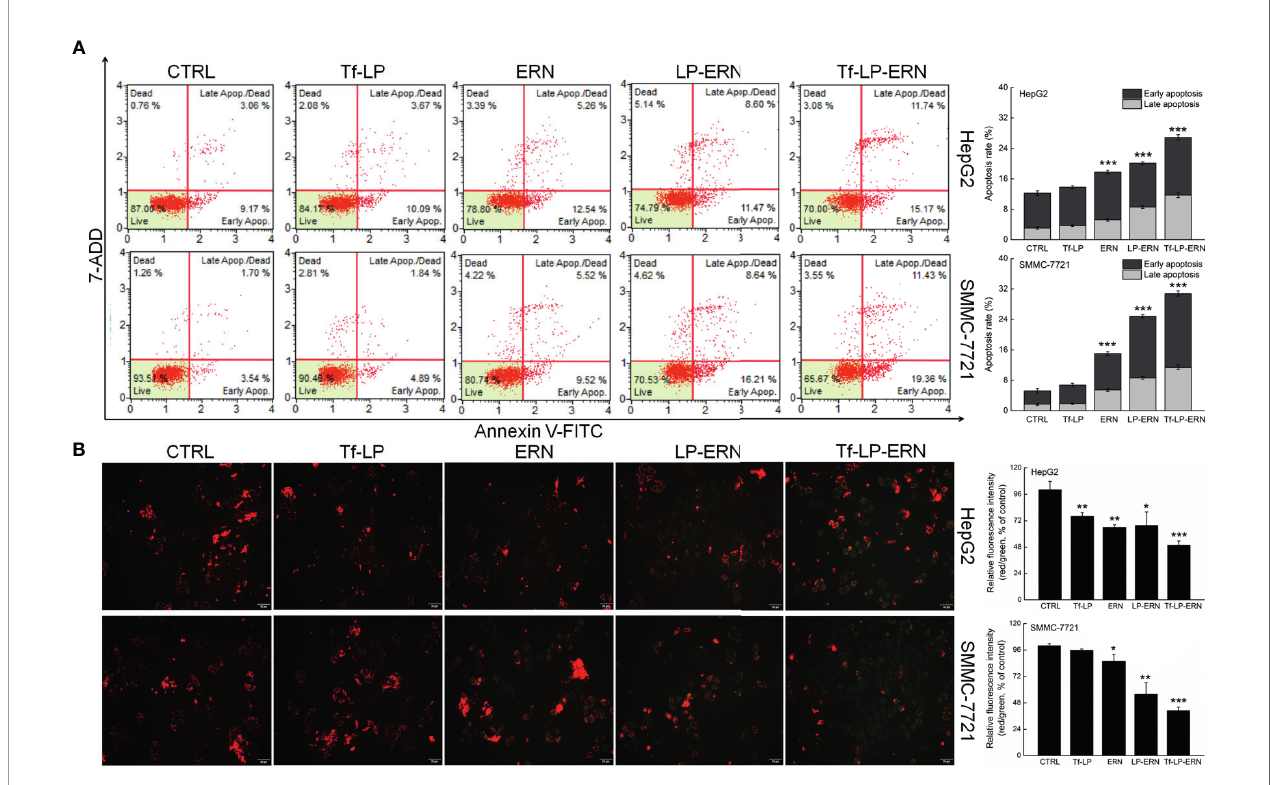
FIGURE 2 | ERN, LP-ERN and Tf-LP-ERN induced apoptosis of HepG2 and SMMC-7721 cells by reducing the mitochondrial membrane potential, among which, Tf-LP- ERN showed the best ef fi cacy. ERN, LP-ERN and Tf-LP-ERN strongly (A) enhanced the apoptosis rate (n = 3) and (B) reduced the liver cancer cells mitochondrial membrane potential (magni fi cation: 200, scale bar: 50 m m) (n = 3). Qualitative data of mitochondrial membrane potential are expressed as the ratio of red to green fl uorescence intensity. * P < 0.05, ** P < 0.01 and *** P < 0.001 vs. control